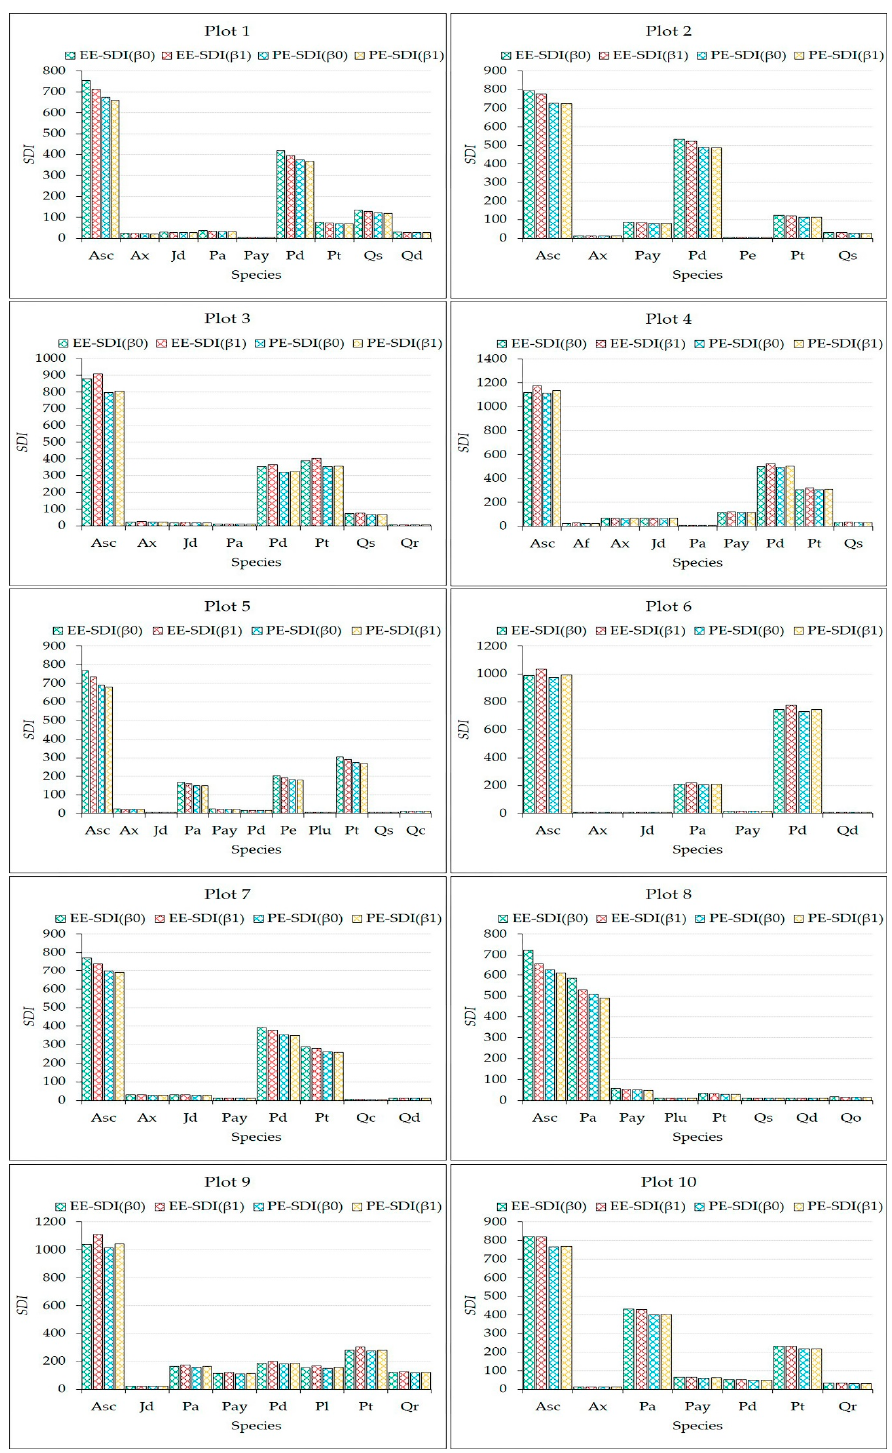
Figure 6. SDIs for mixed-species plots; Asc = All species combined; Af = Alnus firmifolia ; Ax = Arbutus xalapensis ; Jd = Juniperus deppeana ; Pa = Pinus arizonica ; Pay = Pinus ayacahuite ; Pd = Pinus durangensis ; Pe = Pinus engelmannii ; Pl = Pinus leiophylla ; Plu = Pinus lumholtzii ; Pt = Pinus teocote ; Qs = Quercus sideroxyla ; Qc = Quercus crassifolia ; Qd = Quercus durifolia ; Qo = Quercus obtusata ; Qr = Quercus resinona ; EE-SDI ( β 0) and EE-SDI ( β 1) = SDIs based in exponential equation (Equations (2) and (3), respectively); PE-SDI ( β 0) and PE-SDI ( β 1) = SDIs based in potential equation (Equations (7) and (8),